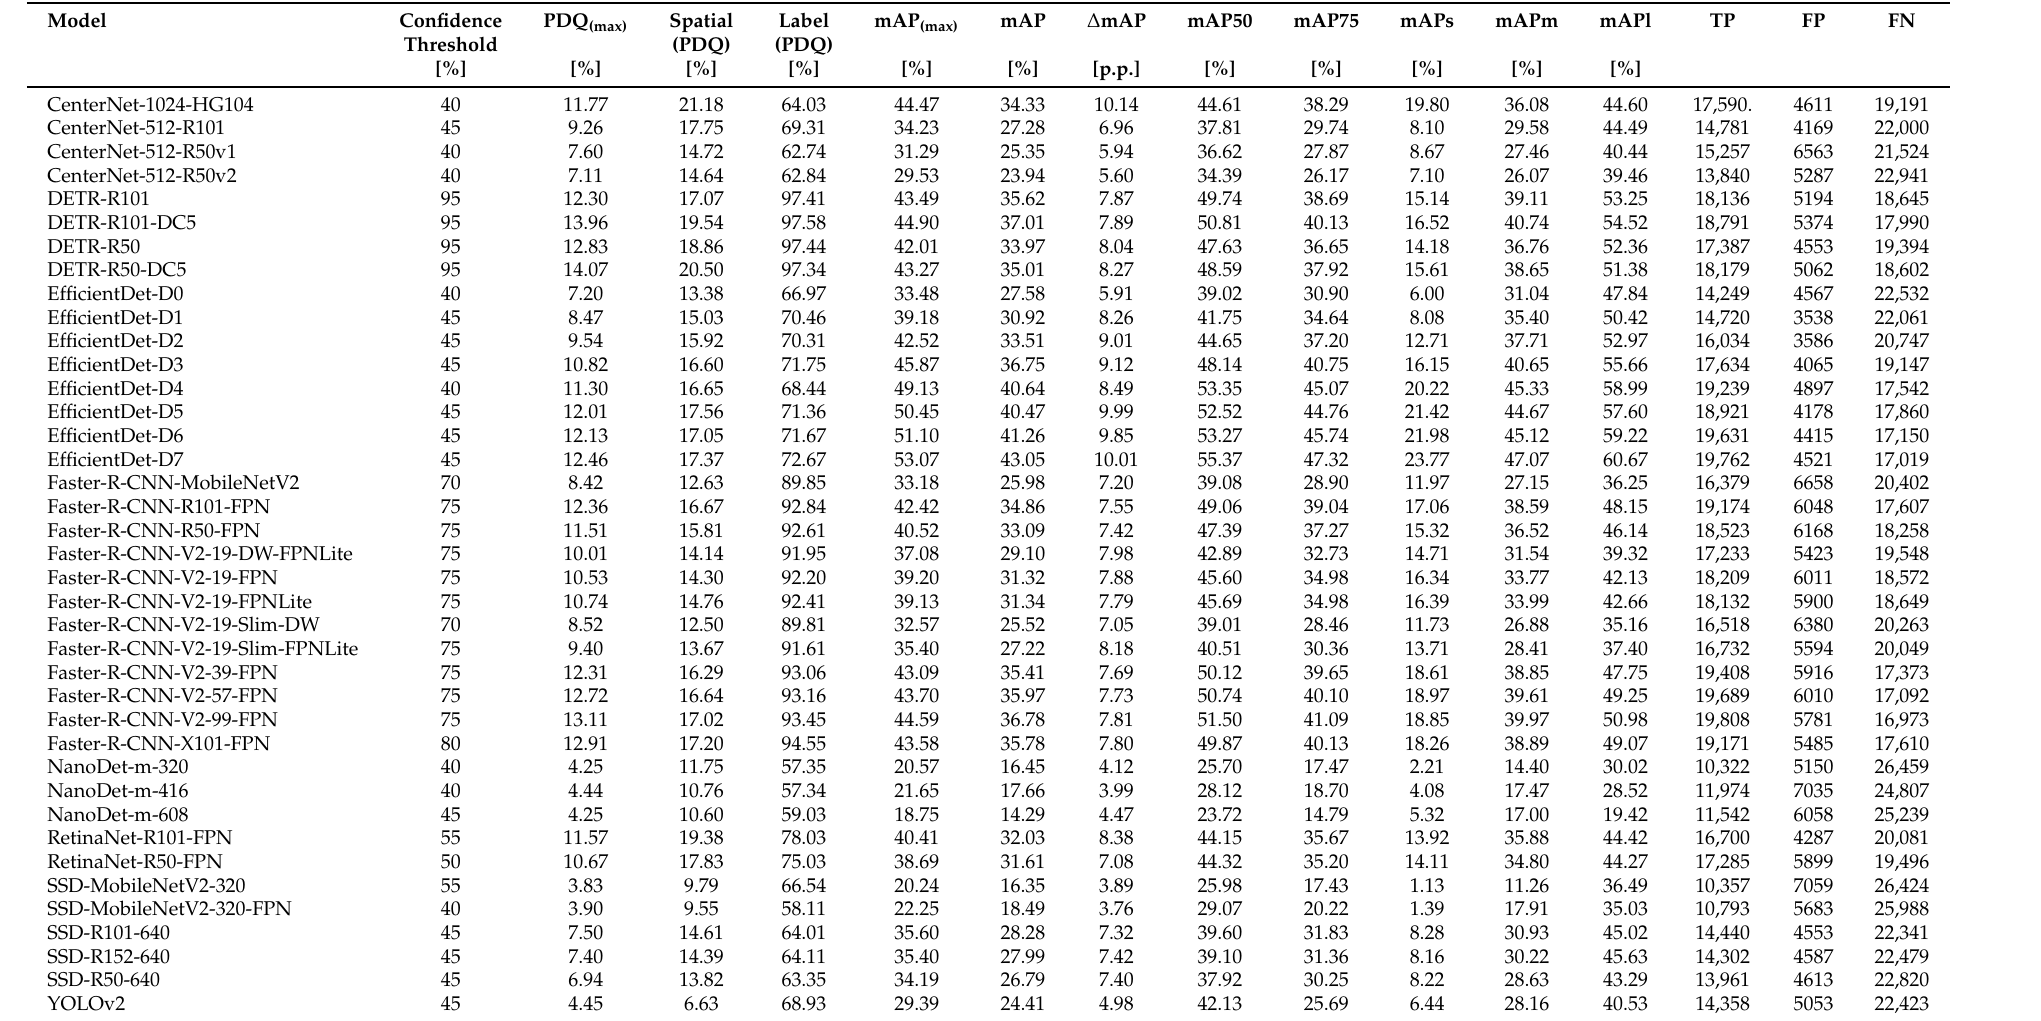
Table 2. COCO metrics comparison at PDQ max